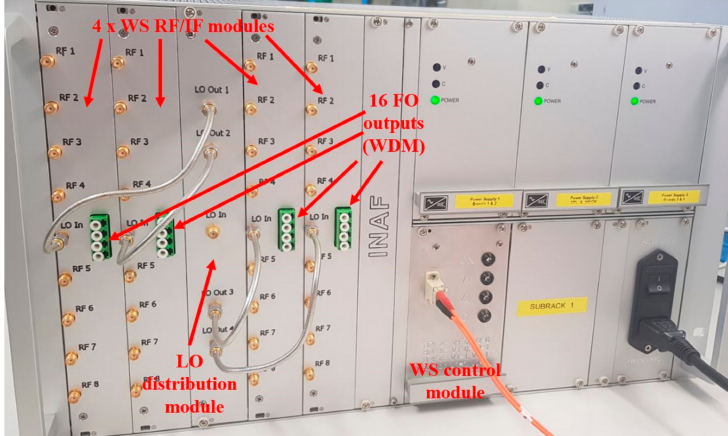
Figure 16. Fully assembled 32-channel receiver showing the four WS RF / IF modules assembled with LO distribution module and WS control module arranged in a standard 19-inch × 6U